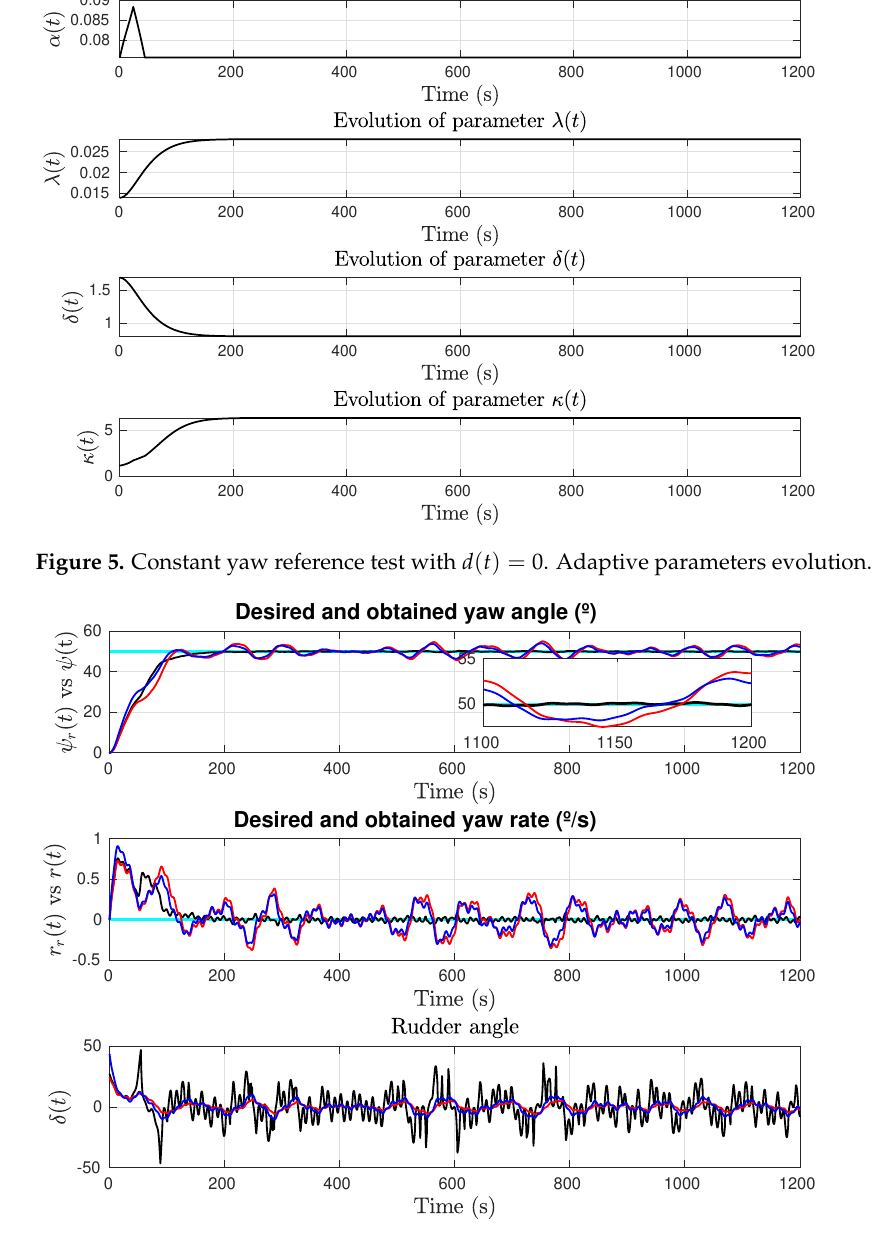
Figure 6. Constant yaw reference test with d ( t ) (cid:54) = 0. States and control. Cyan line: Reference; Red line: Concise backstepping (Zhang et al.); Blue line: Synergetic (Muhammad et al.); Black line: Adaptive sliding mode (González-Prieto et